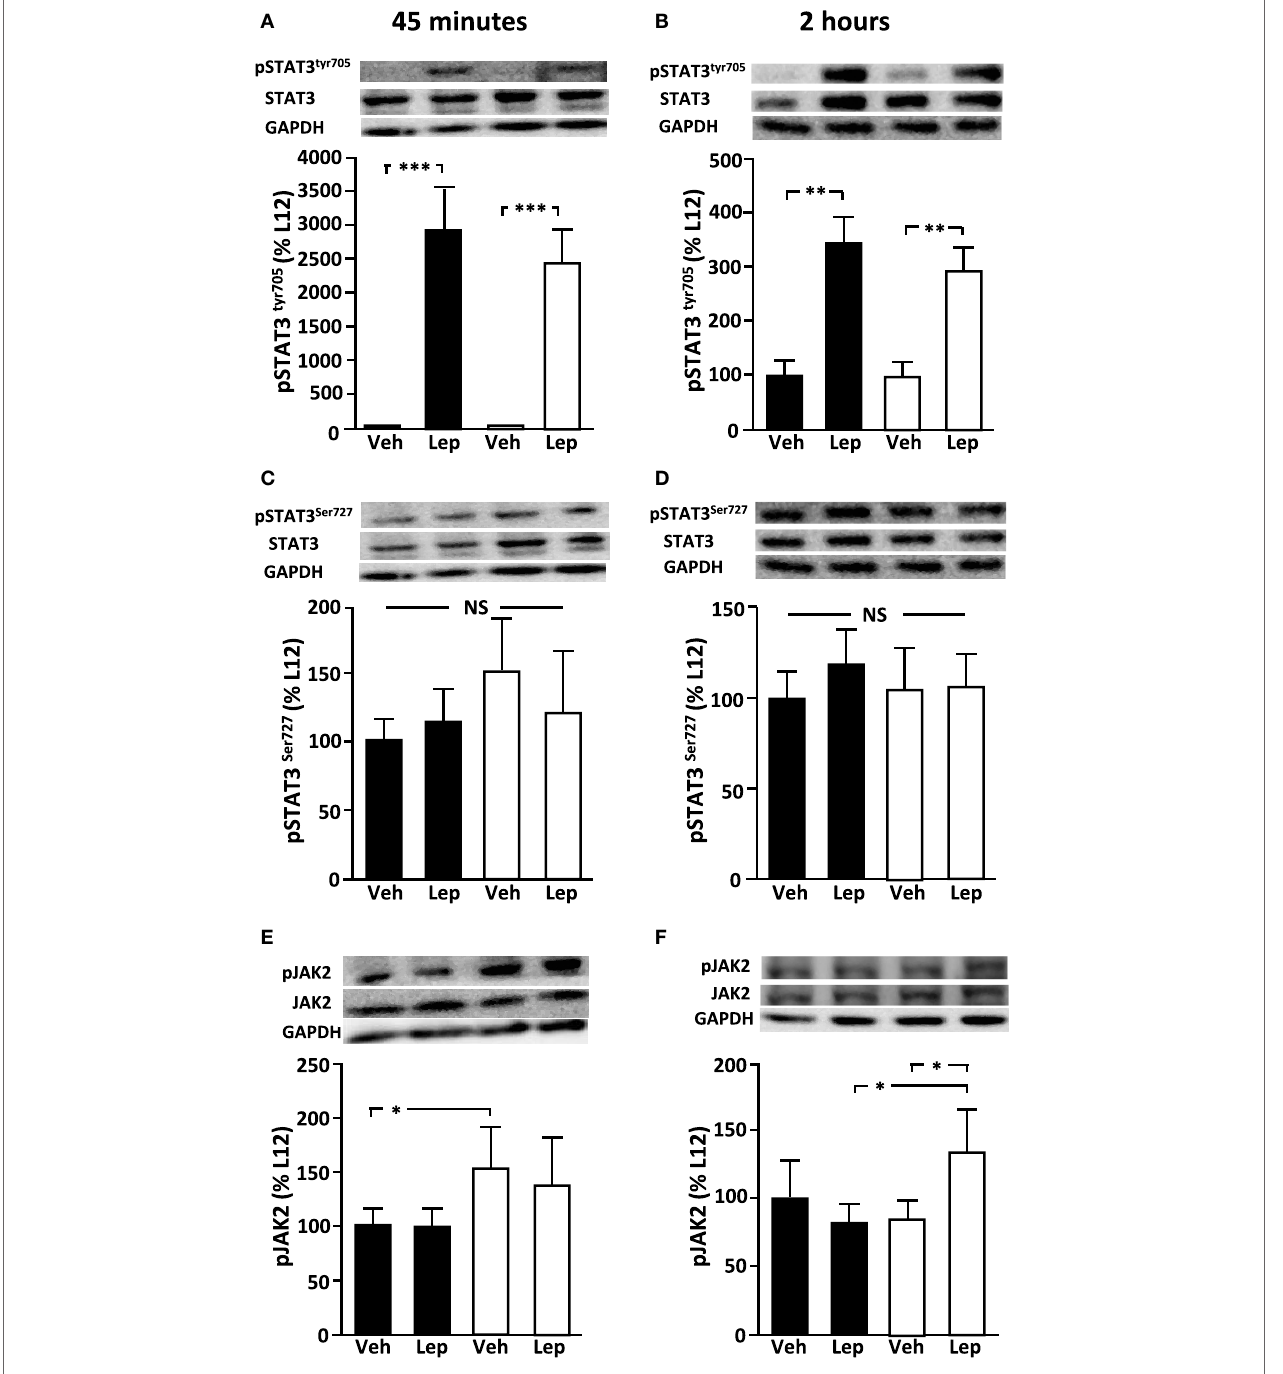
FigUre 3 | Relative levels of (a,B) pSTAT3 tyr705 , (c,D) pSTAT3 ser727 , and (e,F) pJAK2 in the hypothalamus of peripubertal male rats at 45 min (left panel) and 2 h (right panel) after either vehicle (Veh) or leptin (Lep; 3 µg/g body weight) administration. Representative western blots are shown for each protein. Black bars: males raised in litters of 12 pups. White bars: rats raised in litters of 4 pups. * p < 0.05; ** p < 0.01. NS, non-significant ( n = 6/group). Results are presented as mean ± SEM.